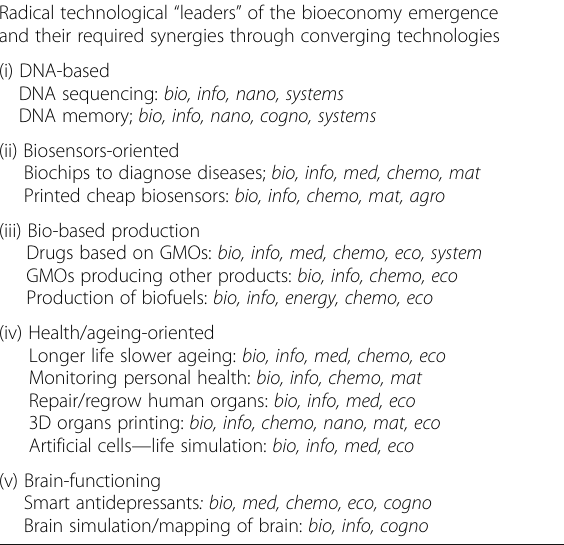
Table 5 The contribution of converging technologies to the emergence of